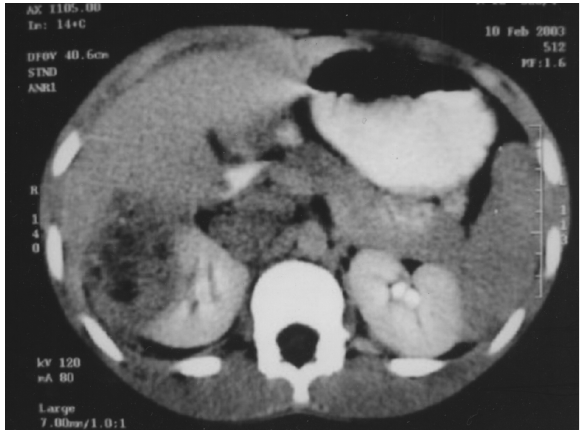
Figure 1 – Computerized tomography evidencing right renal